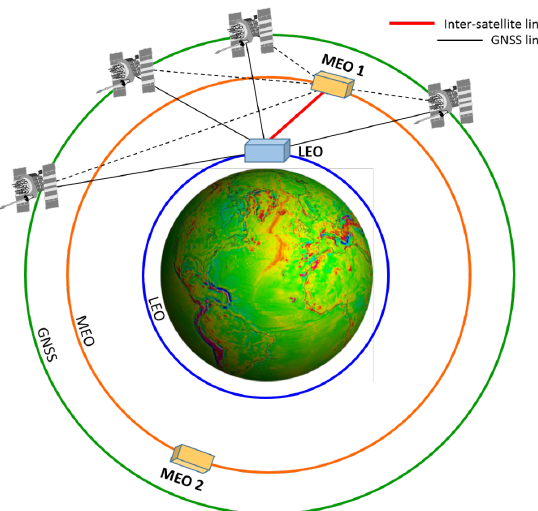
Fig. 2. MOBILE mission constellation: high-precision inter-satellite links between LEO and MEOs (red), micro-wave links from GNSS satellites to MEOs and LEO